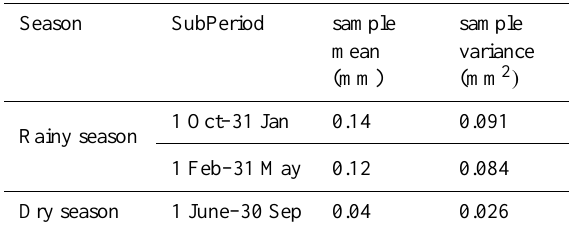
Fig. 4. Memory extension (rainy season) referred to the Cosenza Raingauge. Table 1. Cosenza raingauge: sample means and variances for three subperiods of the